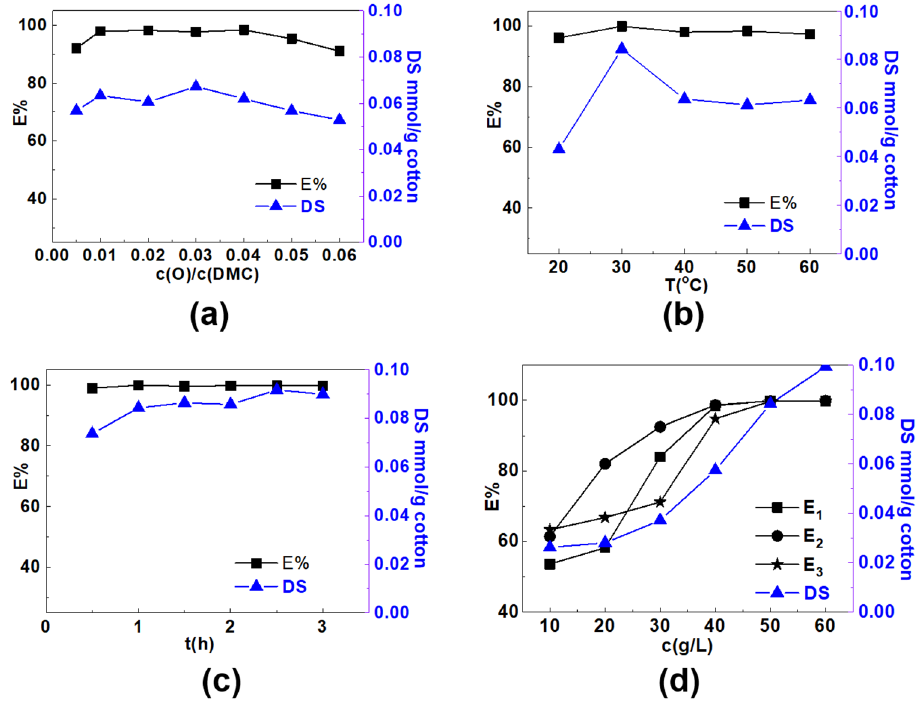
Figure 2. Influence of ( a ) mole ratio of K 2 S 2 O 8 to DMC (concentration of DMC is 50 g/L, T = 40 °C and t = 3 h); ( b ) reaction temperature (concentration of DMC is 50 g/L, mole ratio of K 2 S 2 O 8 to DMC is 0.01:1 and t = 3 h); and ( c ) reaction time (concentration of DMC is 50 g/L, mole ratio of K 2 S 2 O 8 to DMC is 0.01:1 and T = 30 °C) on the DS of cotton and E% of C. I. Reactive Blue 19. ( d ) Influence of DMC concentration on DS and E% of C. I. Reactive Blue 19 (E 1 ), C. I. Reactive Red 195 (E 2 ) and C. I. Reactive Yellow 145 (E 3 ) (mole ratio of K 2 S 2 O 8 to DMC is 0.01:1, T = 30 °C and t = 1 h).